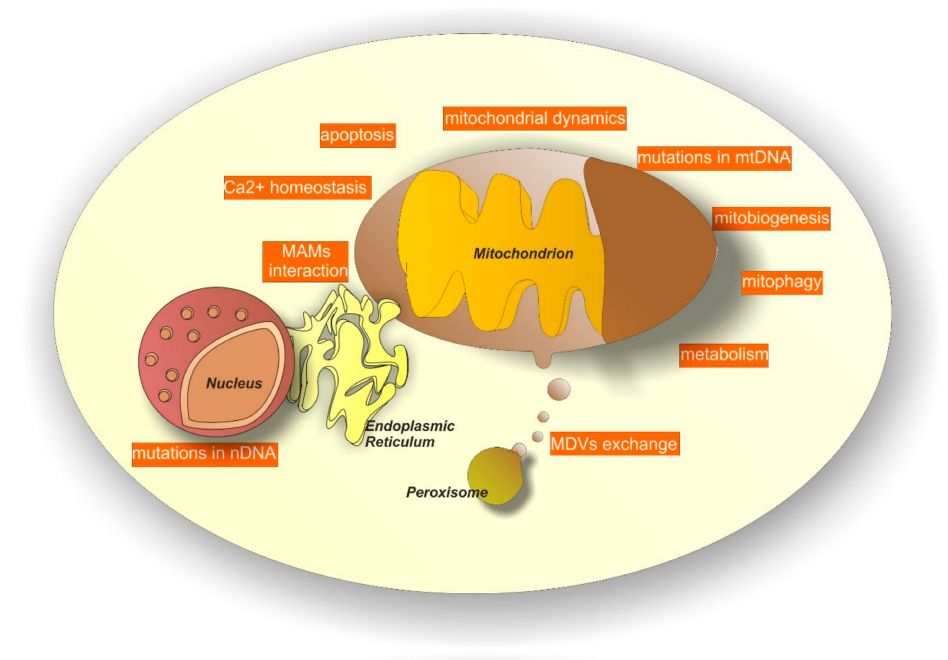
Figure 2. Mitochondrial dependent mechanisms in neurodegeneration. Mitochondria contribute to neurodegeneration by several mechanisms, including alterations in calcium homeostasis,